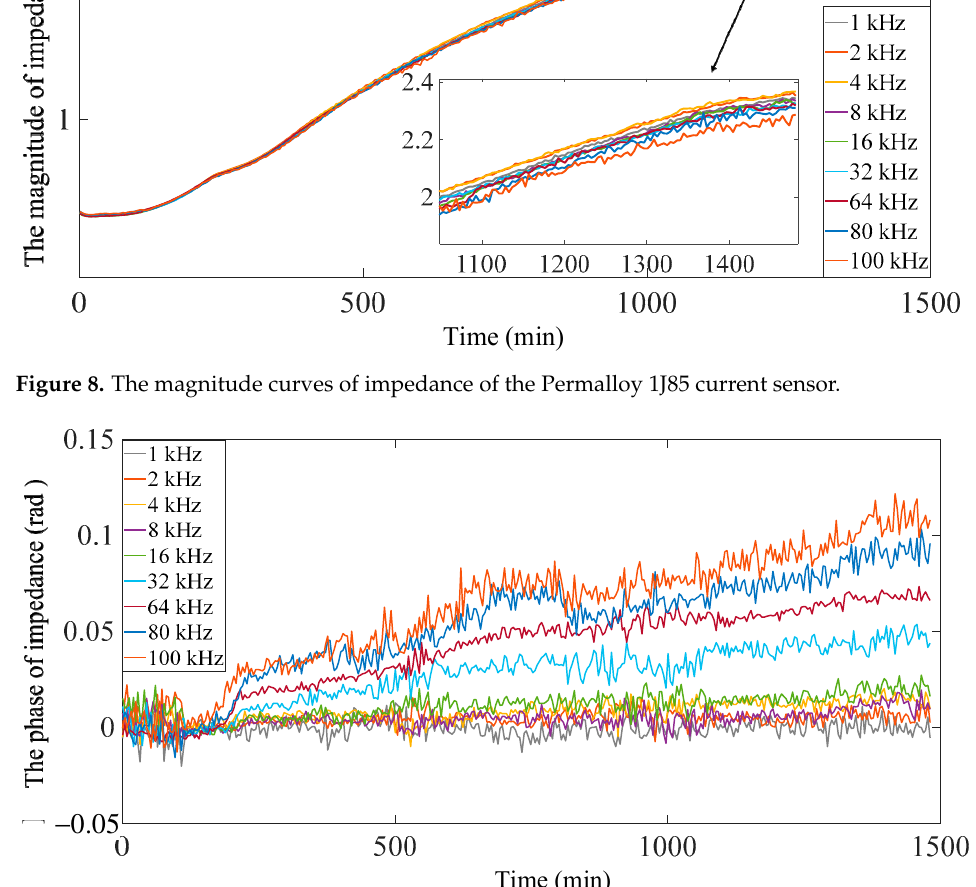
Figure 9. The phase curves of impedance by the Permalloy 1J85 current sensor.